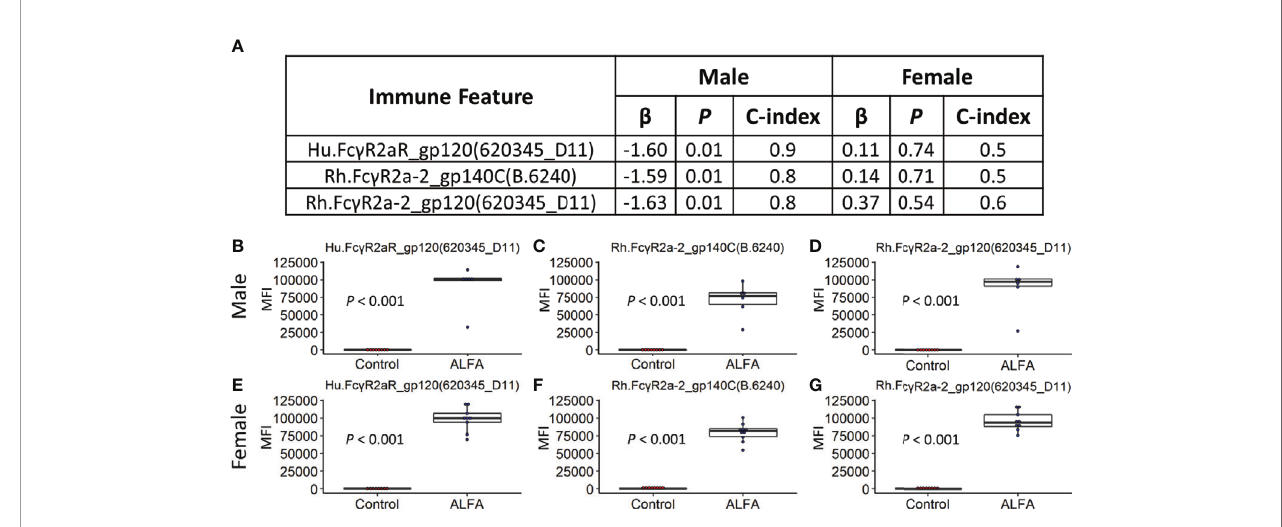
FIGURE 5 | Sex-speci fi c ef fi cacy and vaccine-elicited immune responses. (A) Cox regression analysis for Male and Female subjects on three most important immune features identi fi ed by random forest models. (B – D) Vaccine-elicited immune responses of Male subjects in the ALFA arm. (E – G) Vaccine-elicited immune responses of Female subjects in the ALFA arm. MFI, Median Fluorescence